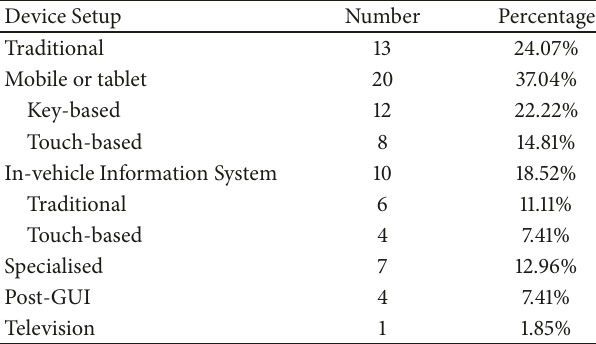
Table 9: Summary of the distribution of primary studies’ device